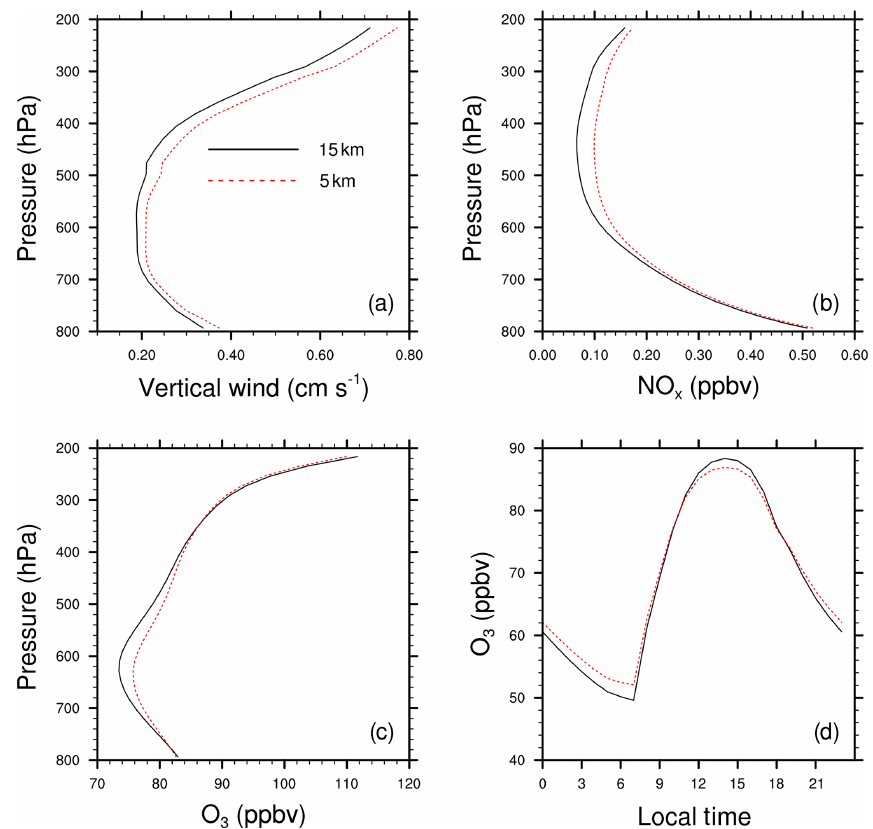
Figure 8. Domain average profiles of vertical wind, NO x , and O 3 concentrations (a–c) and domain average diurnal variations in surface O 3 over July (d)